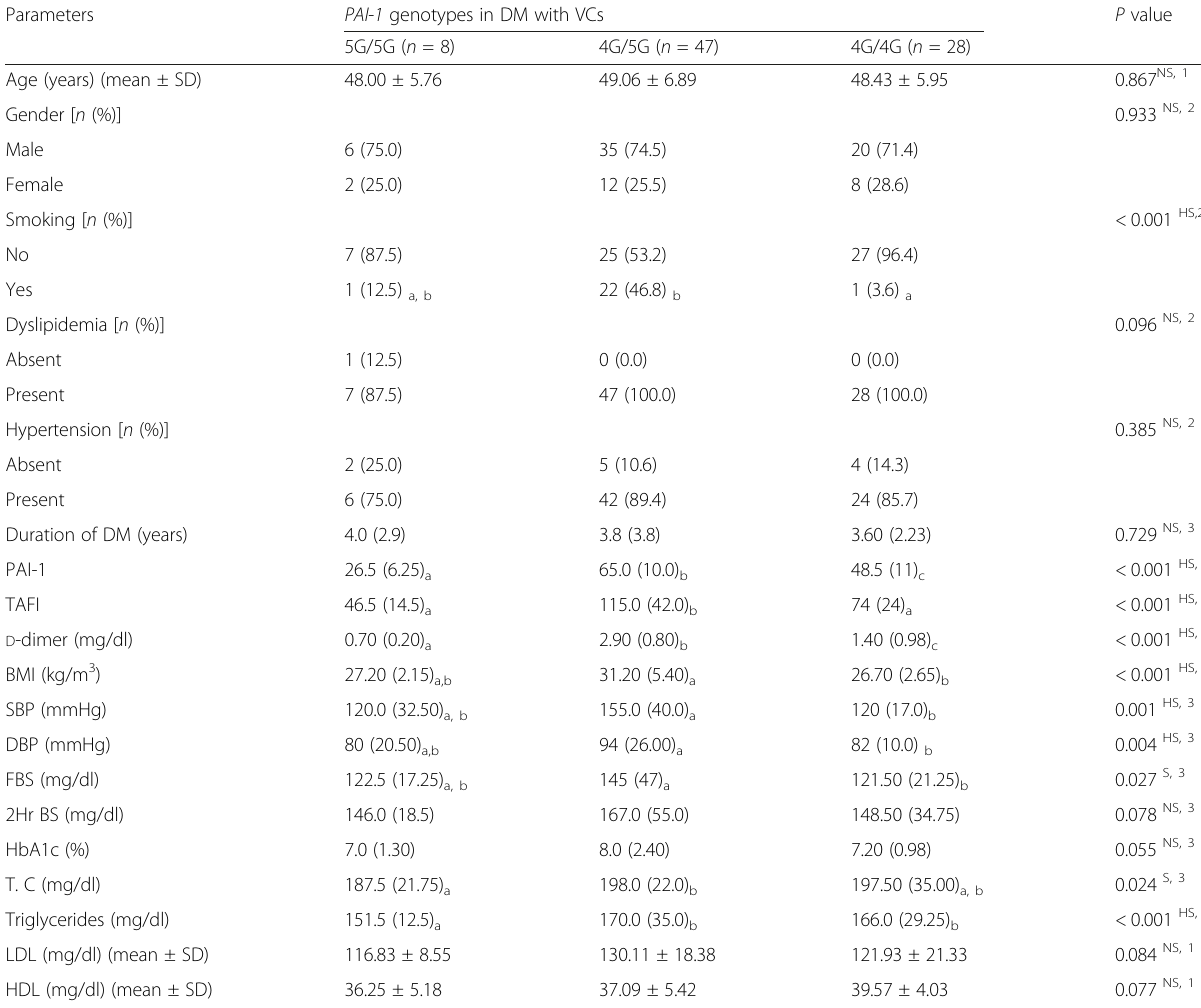
Table 4 Comparison between the genotypes of PAI - 1 regarding demographic and clinical data in diabetes with vascular complication